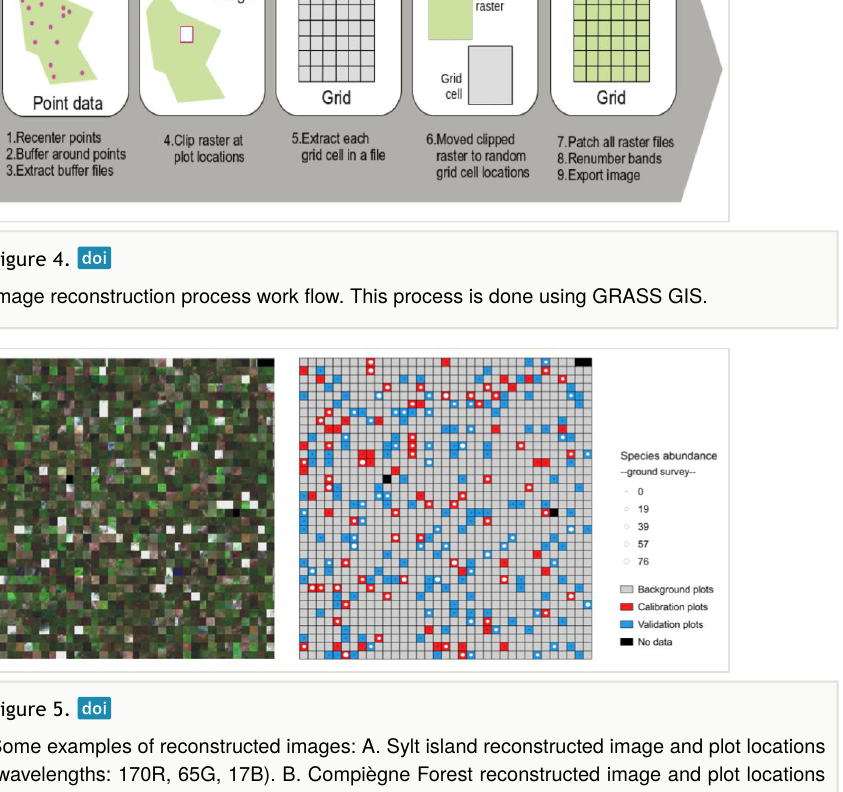
The dataset consists of two such reconstructed hyperspectral images with 248 spectral bands and spatial resolutions of 1.8 m x 1.8 m (Fig. 5A) and 3 m x 3 m (Fig. 5B) for the island of Sylt (Germany) and for the forest of Compiègne (France), respectively. A set of LiDAR-derived rasters with the same spatial resolutions and, a corresponding table of plot- based fi eld. The fi eld data include repositioned geographical coordinates (in the reconstructed image space), grid categories (i.e. calibration, validation, background) and the percentage cover of the invasive alien moss species Campylopus intro fl exus (Hedw.) Brid., 1819 (Sylt island) and the invasive alien tree species Prunus serotina Ehrh., 1788 (forest of Compiègne). Additional fi eld data are provided for the forest of Compiègne on the community weighted mean of leaf phosphorus and nitrogen concentration for plots with varying native and alien invasive species abundance. The original remote sensing data were acquired in two fl ights and fi eld campaigns within the DIARS project. For Sylt island, an APEX (Airborne Prism Experiment) sensor covering a spectral range between 412 and 2432 nm was used by The Flemish Institute for Technological Research (VITO) to acquire